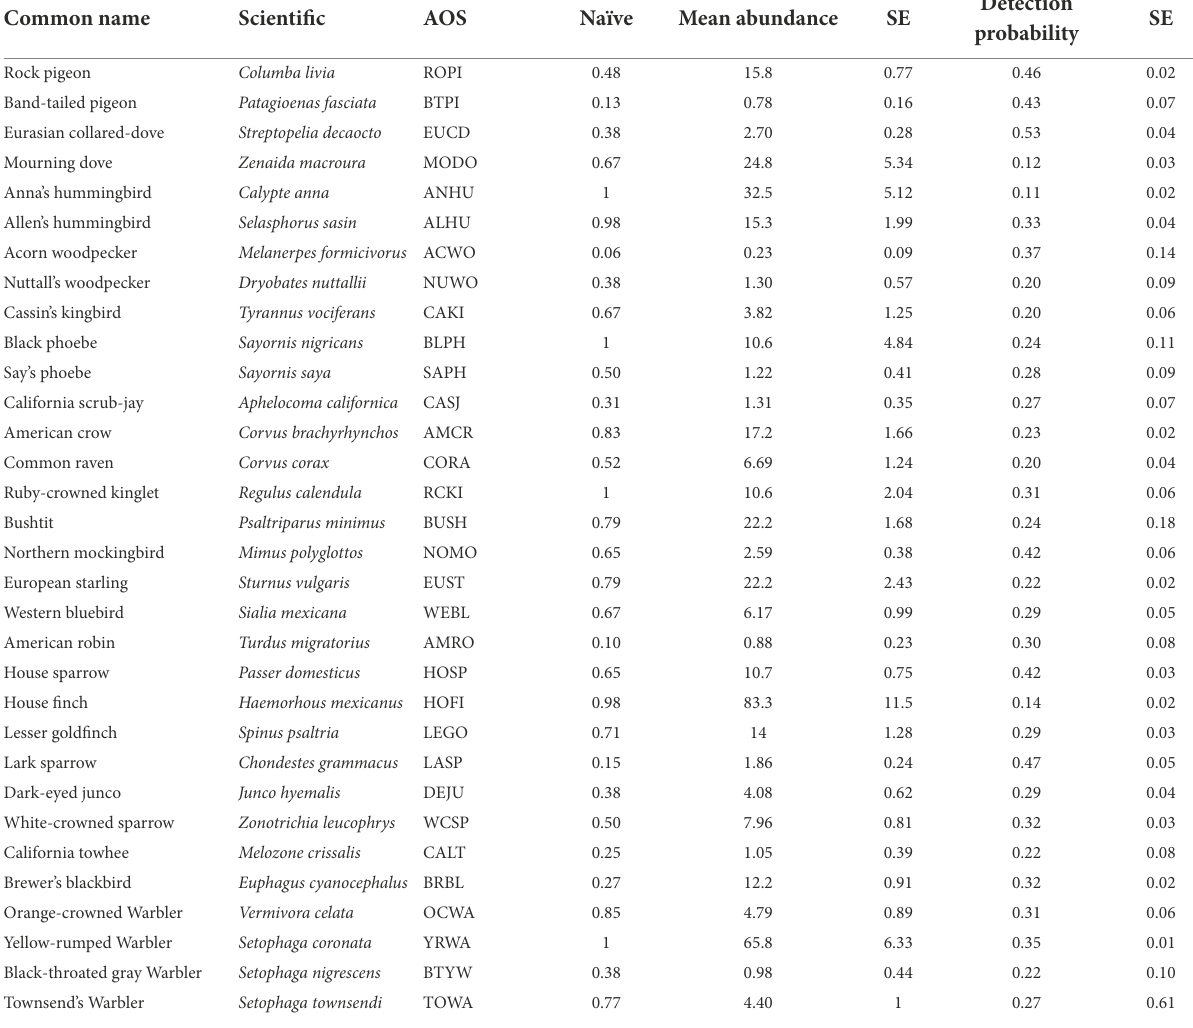
TABLE 1 Common, scientific names, and the American Ornithological Society (AOS) alpha 4-letter bird codes (Chesser et al., 2021) for 33 species included in the N -mixture modeling